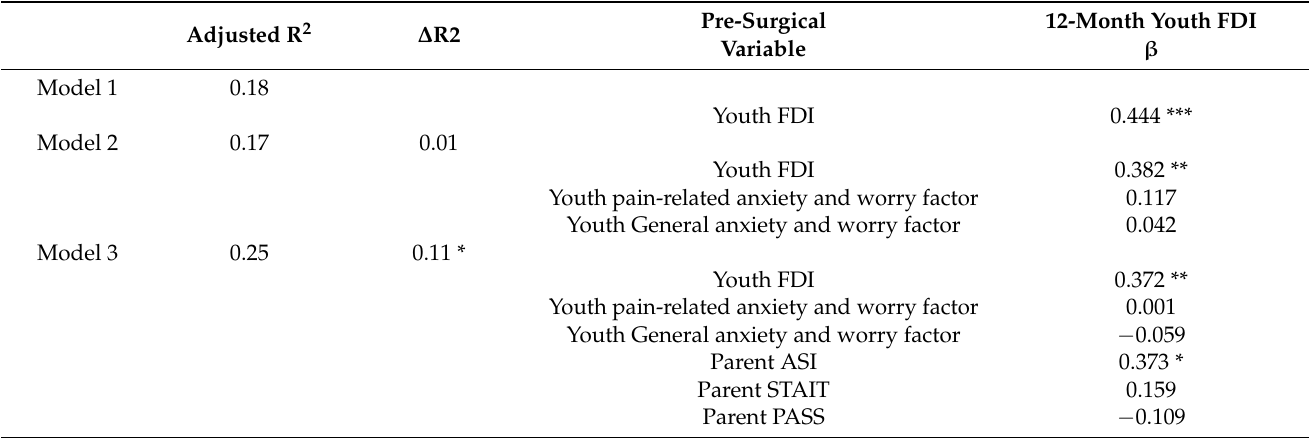
Table 2. Standardized regression coefficients ( β ) from multivariable regression analyses predicting 12-month youth FDI from youth and parent pre-surgical risk factors.